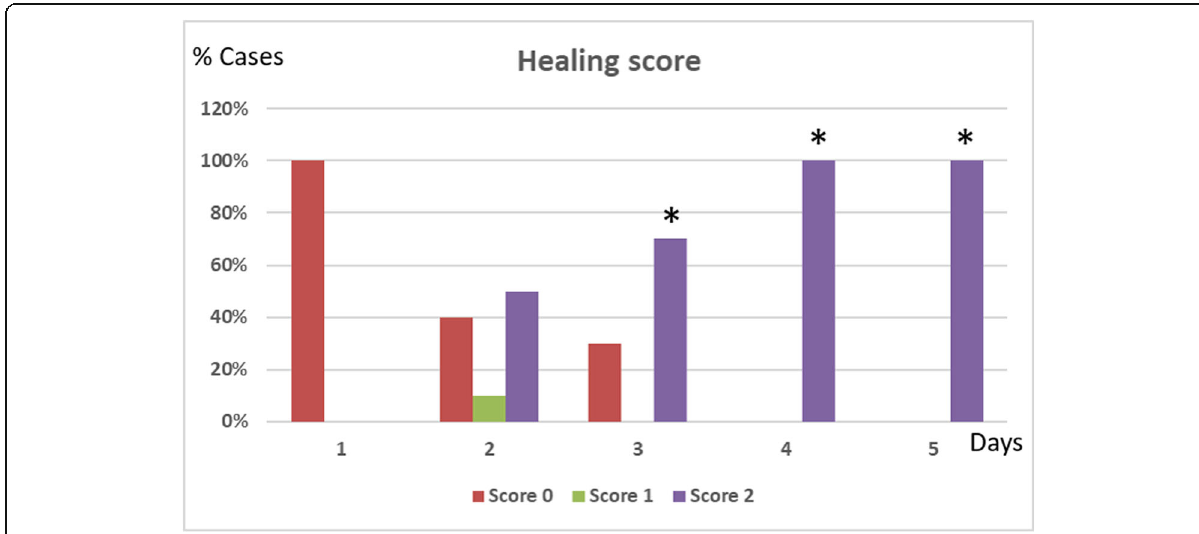
Fig. 3 Graphical presentation of gingival wound healing for laser (test) and control groups during the study period. At day 1, all cases showed same healing (score 0). Starting from day 3, better healing was observed in laser than control group (score 2). Score 0: control and laser-treated sites showed the same healing extent. Score 1: better healing was observed for control than laser treated sites. Score 2: better healing was observed for laser treated than control sites. (* significant difference, p < 0.05)